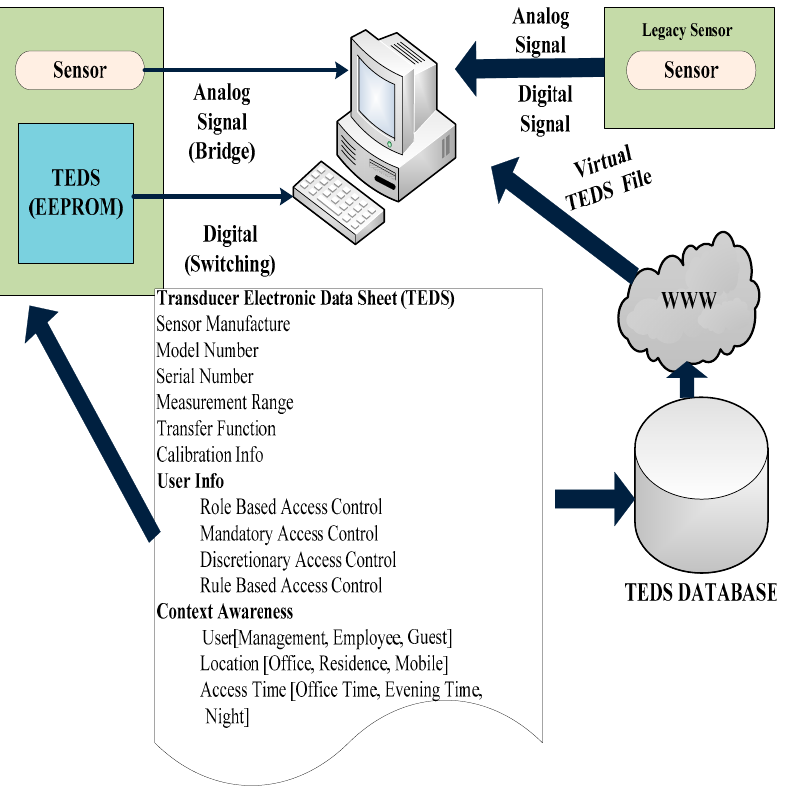
Figure 2. Integration of virtual TEDS systems in IEEE 1451.